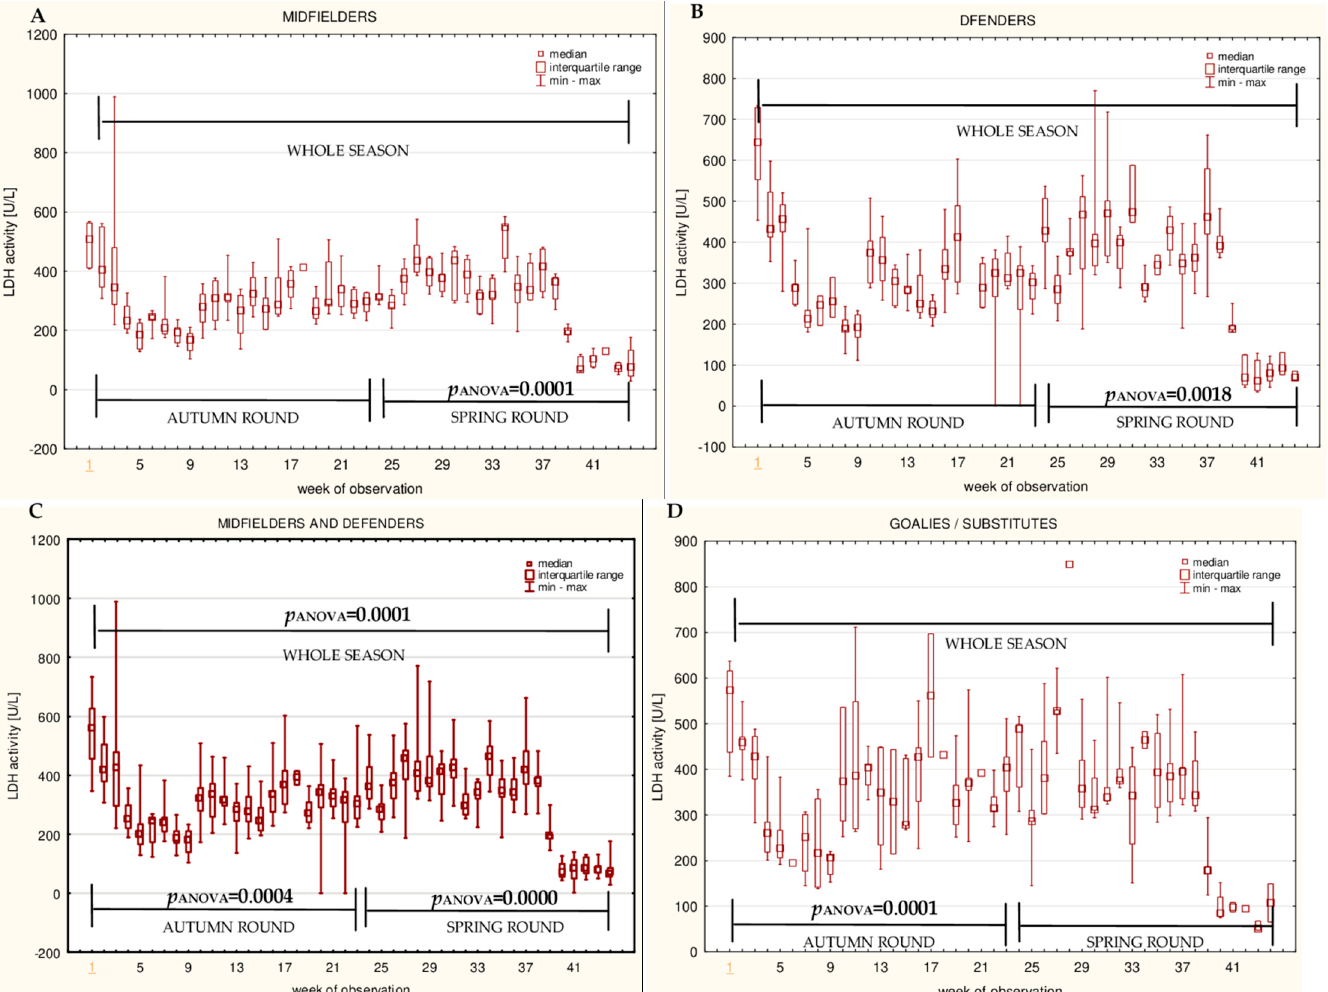
Figure 4. Median lactate dehydrogenase (LDH) activities in: ( A ) The midfielder, ( B ) defender, ( C ) midfielder/defender and ( D ) goalie/substitute subgroups over the course of the soccer match season.